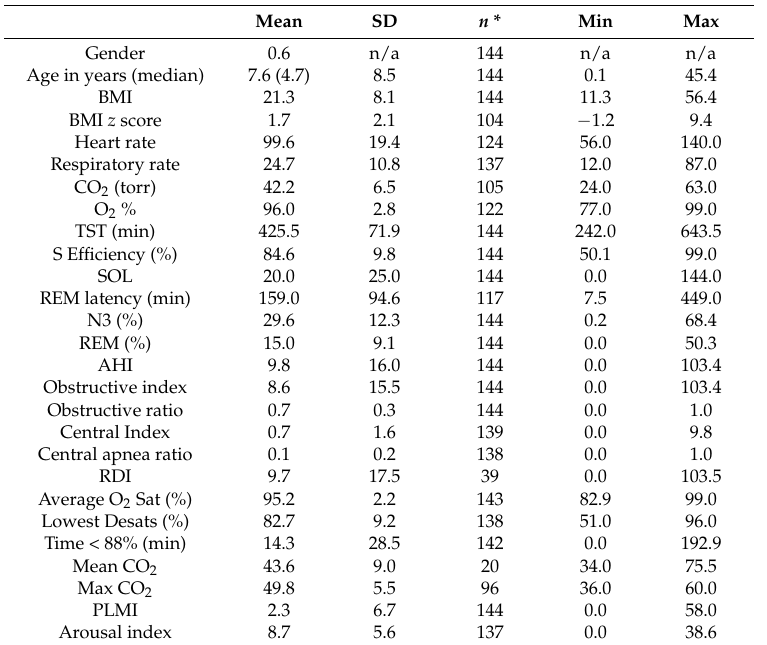
Table 1. Demographics data and basic polysomnographic characteristics ( n =